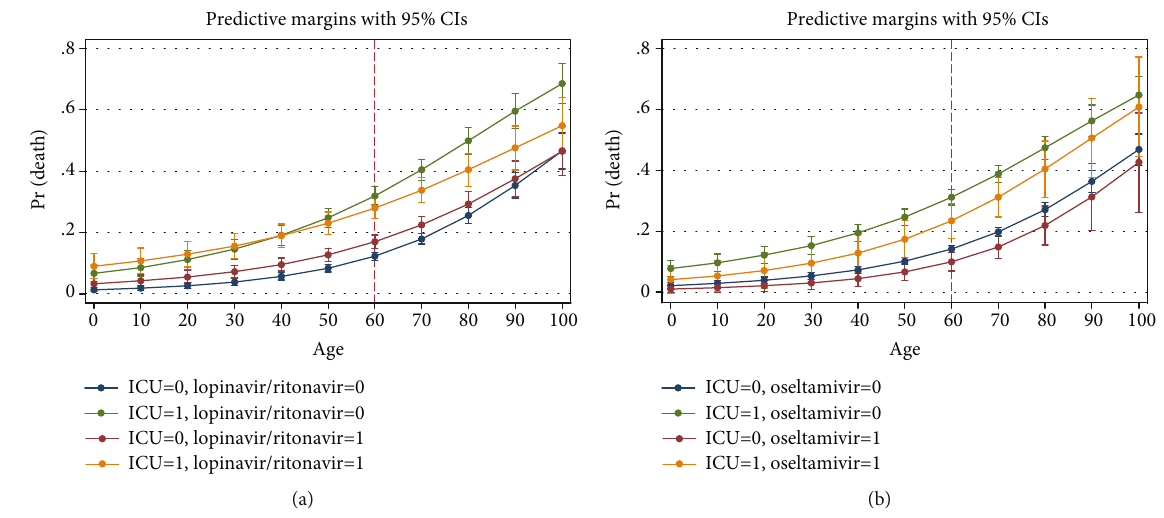
Figure 7: Association of lopinavir/ritonavir (a) and oseltamivir (b) with probability of death based on age and ICU admission (from logistic regression of Table 3, step